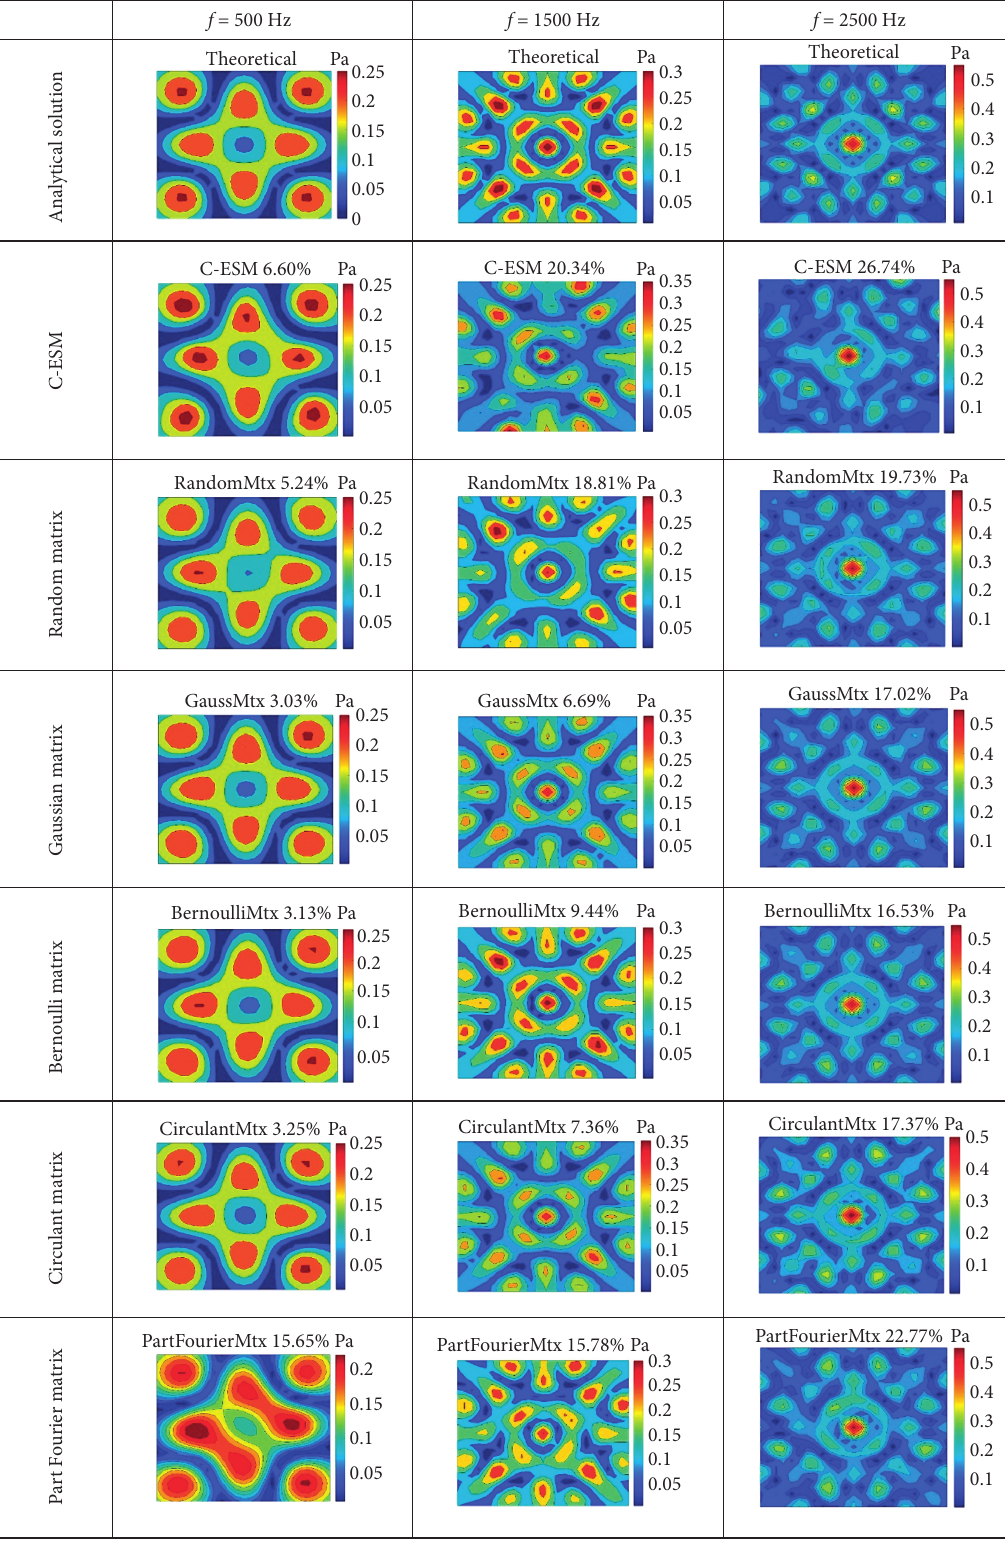
Figure 4: Reconstructed and theoretical acoustic pressure nephogram of six